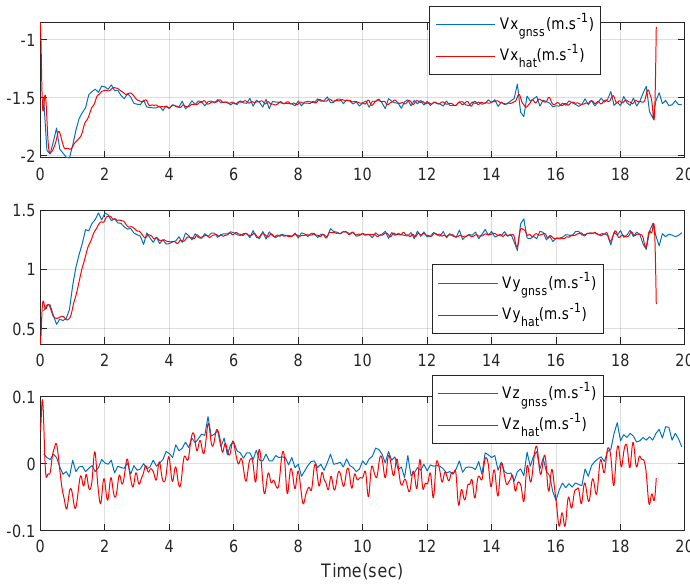
Figure 13. The 3-axis velocities of the rover: a straight driving